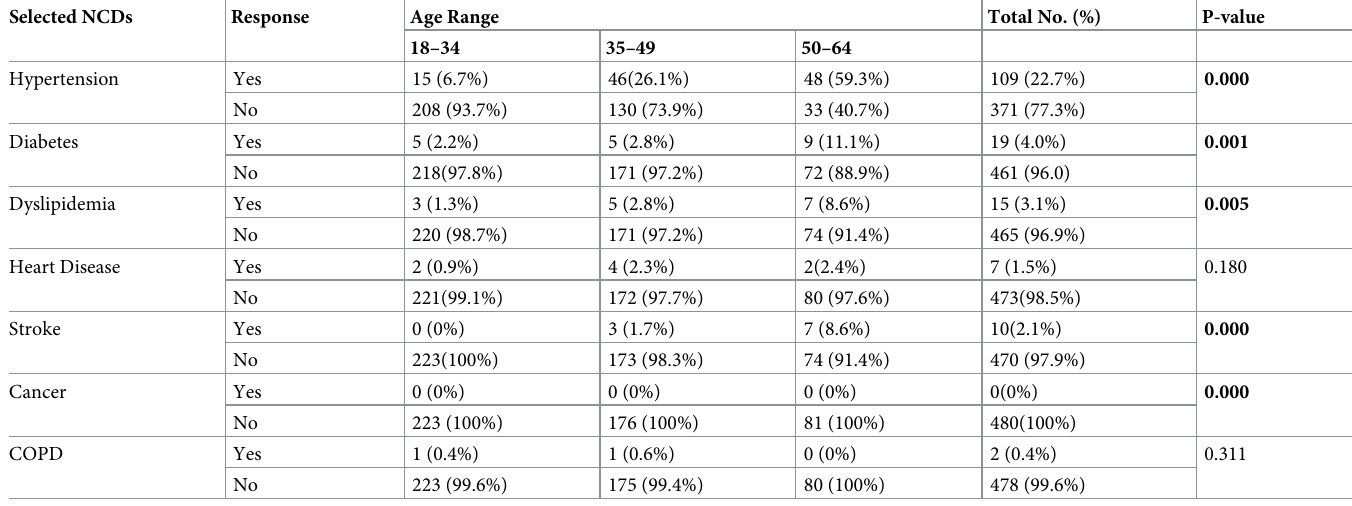
Table 3. Prevalence of selected